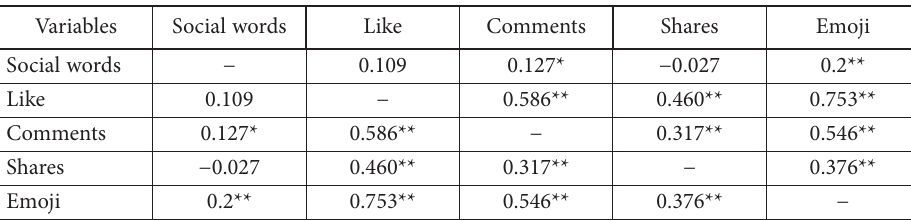
Table 3. Correlation among variables (N =